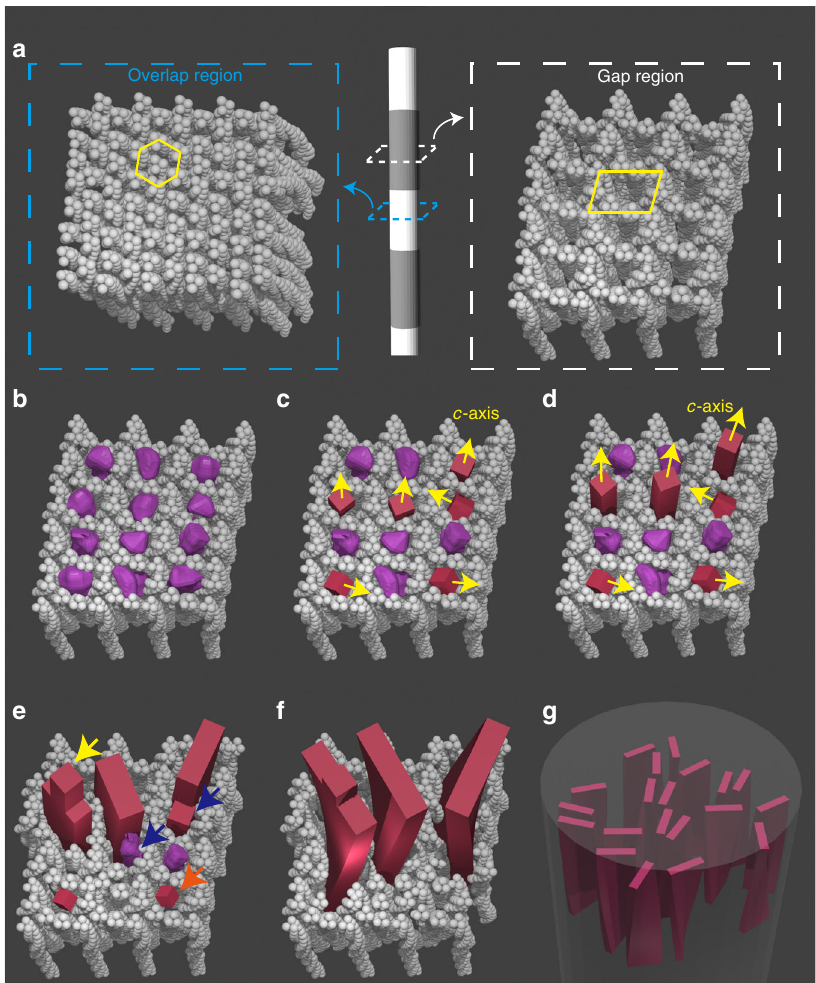
Fig. 6 Schematic representation of the proposed con fi nement model for collagen mineralization. The model is based on the X-ray crystal structure of the collagen fi bril in Fig. 3, a where the overlap regions consist of tilted molecules which are densely packed in a quasi-hexagonal pattern (highlighted by yellow lines), and the gap regions contain straight channels (highlighted by yellows lines) allowing HAp nucleation. The channels are initially fi lled with ACP phase (purple particles in b ), which through an amorphous-to-crystalline transformation form HAp nuclei (red particles in c ). Nuclei with their fast growing c -axes parallel to the channels out-compete those with other orientations ( d ), and develop into platelets by pushing aside the collagen molecules, as shown in e . Needle-like tips are left on some platelets (highlighted by yellow arrow). Misoriented nuclei and ACP are either consumed by Ostwald ripening (highlighted by the orange arrow), or fuse with other platelets by adjusting the ionic arrangement 58 (highlighted by blue arrows). The platelets further grow and start to twist around their long axes probably due to the locally changing collagen organization ( f ). This results in the twisted HAp platelets being roughly uniaxially oriented with their c -axis parallel to the long axis of the fi bril ( g